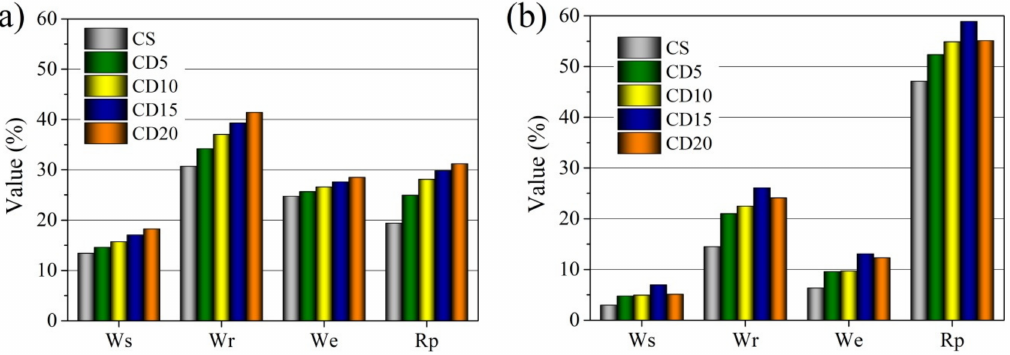
Figure 10. Water absorption (Ws), apparent porosity (Wr), effective porosity (We), and reserve pore volume (Rp), of the ceramic bodies fired at ( a ) 1000 ◦ C and ( b ) 1060 ◦ C.